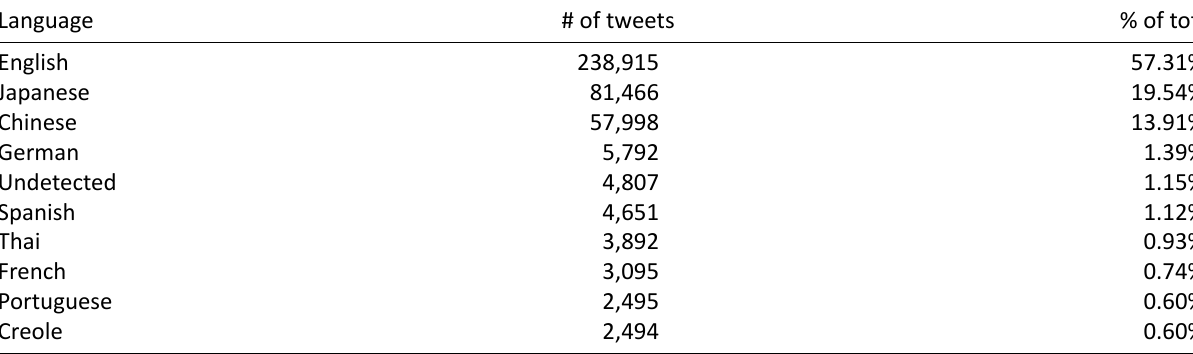
Table 2. Top 10 languages by the number of tweets.